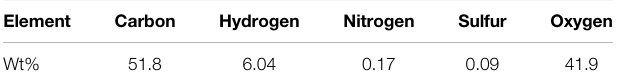
TABLE 3 | Analysis of biomass on dry ash – free basis.